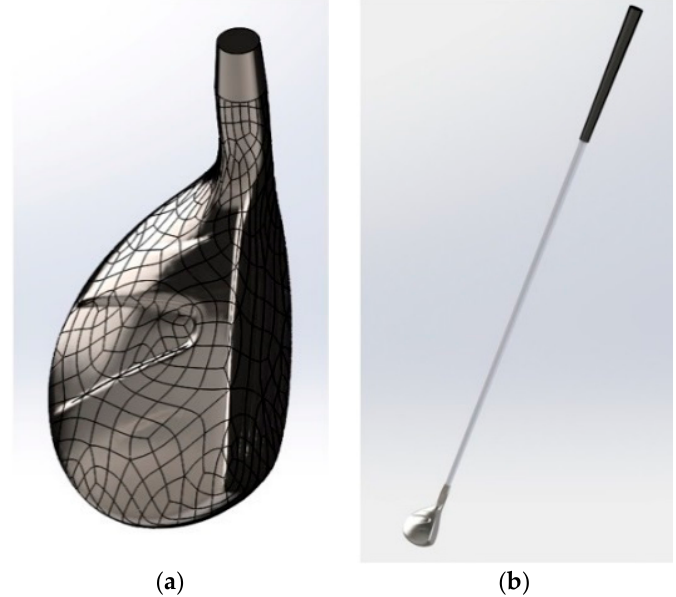
Figure 4. ( a ) Three-dimensional (3D) scan of the head, imported in SolidWorks. ( b ) Whole numerical model of the golf shaft.